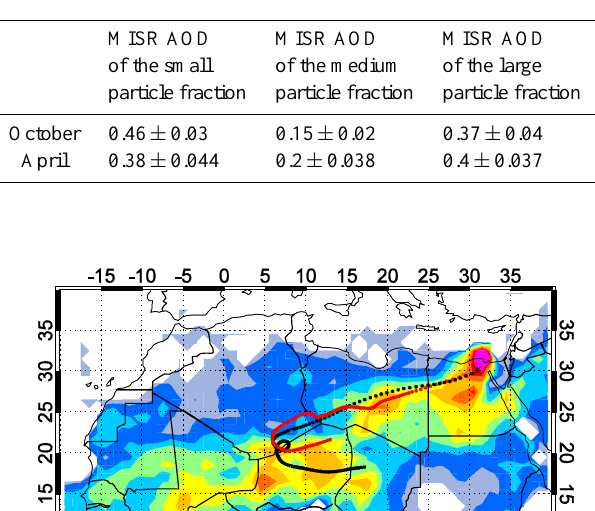
Table 2. MISR AOD monthly mean size fractions for October and April over the period of 2001–2008.